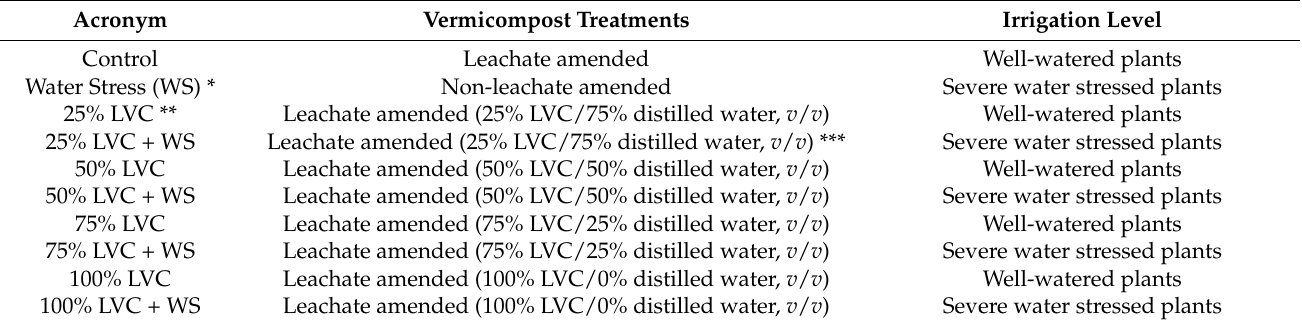
Table 1. Experimental design of the